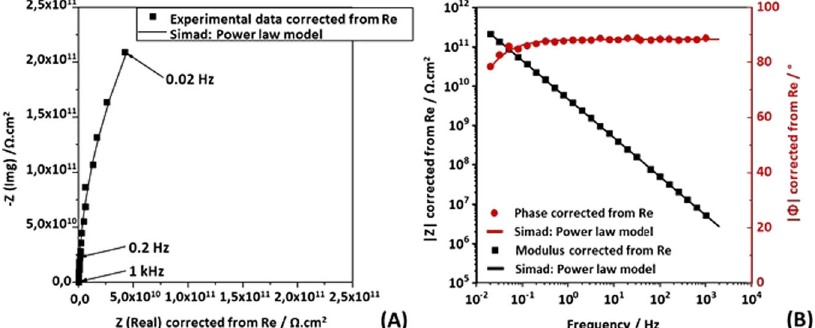
Fig. 2 Nyquist diagram and Bode diagram of undamaged painted steel. The imaginary part (Z(img)) is plotted in function of the real part (Z(Re)) of the impedance for the Nyquist diagram in ( A ). The modulus (black curve) and phase (red curve) are plotted in function of the frequency in ( B ). Both diagrams are corrected by the Re (Electrolyte resistance), with the modelling result obtained from the EEC presented in (Fig. 3, straight lines) and the power low model implemented in the SIMAD ® software, at 20 °C under static condition and in naturally aerated solution.